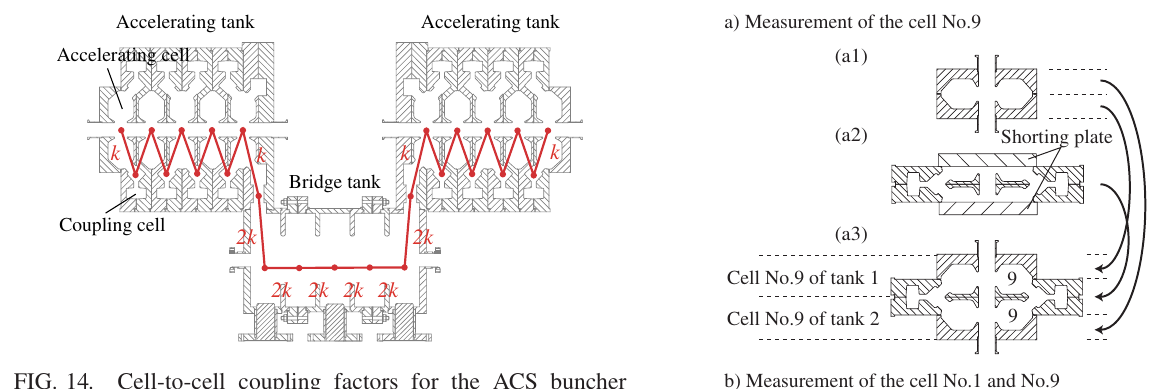
FIG. 14. Cell-to-cell coupling factors for the ACS buncher module. The coupling factor for the bridge tank is designed to be twice as large as that for the accelerating